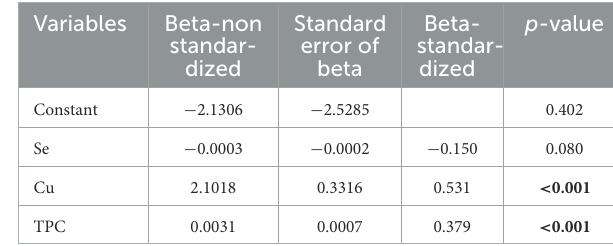
TABLE 4 Regression model for the association between trace elements, total phenolics and FRAP based on multivariable linear regression